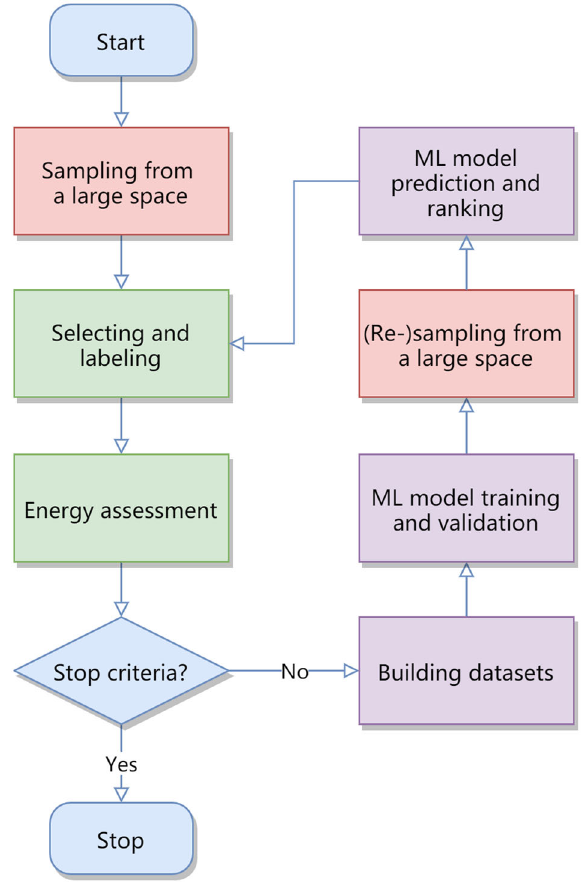
Fig. 4 Flowchart of the active learning-based LAsou method. An overview of the proposed approach for the structure prediction of fi nite-sized chemical-disordered materials coupled with fi rst- principles